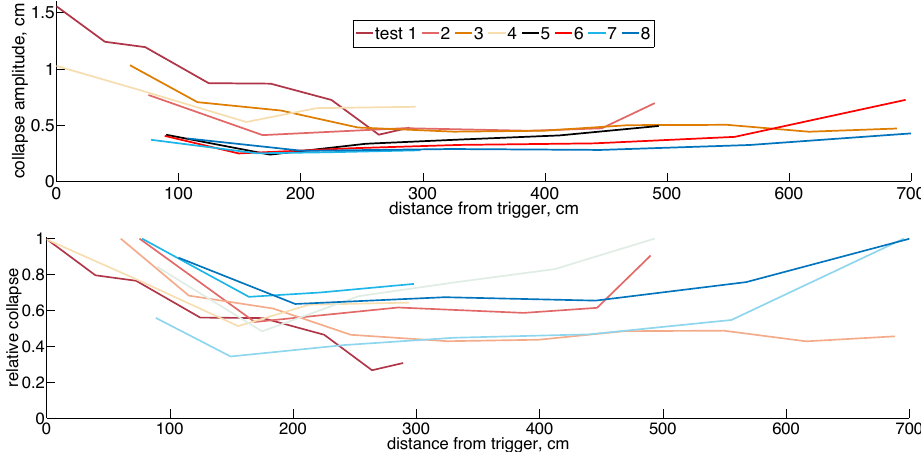
Figure 5 a,b Collapse vs. distance from trigger for tests 1-8 602 Figure 5. (a) Collapse vs. distance from trigger for tests 1–8. Collapse values are total displacements after movement has stopped. Absolute collapse values shown in (a) , collapse values normalized by the maximum collapse in each test shown in (b) .